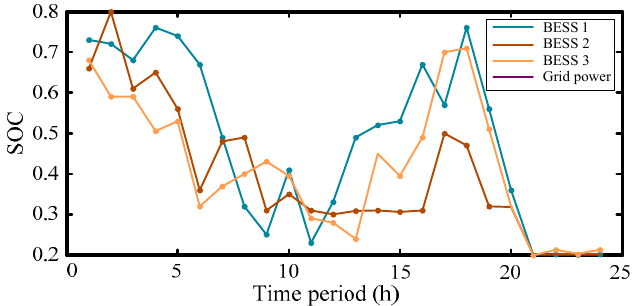
Figure 16. SOC values of multi-BESSes under the situation 1.